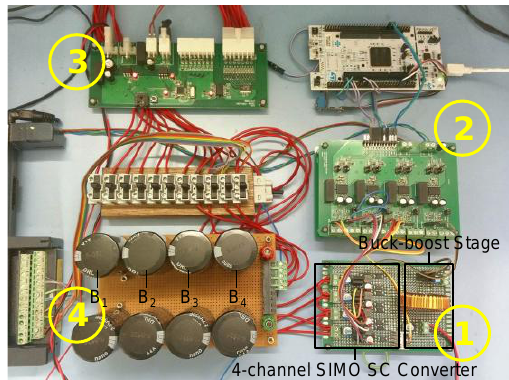
Figure 14. Major components in the experiment setup. (1) String-to-cells SC balancer prototype; (2) microcontroller and gating circuits; (3) LTC6803 based cell monitoring unit; and (4) series connected EDLC cells with fused terminals.